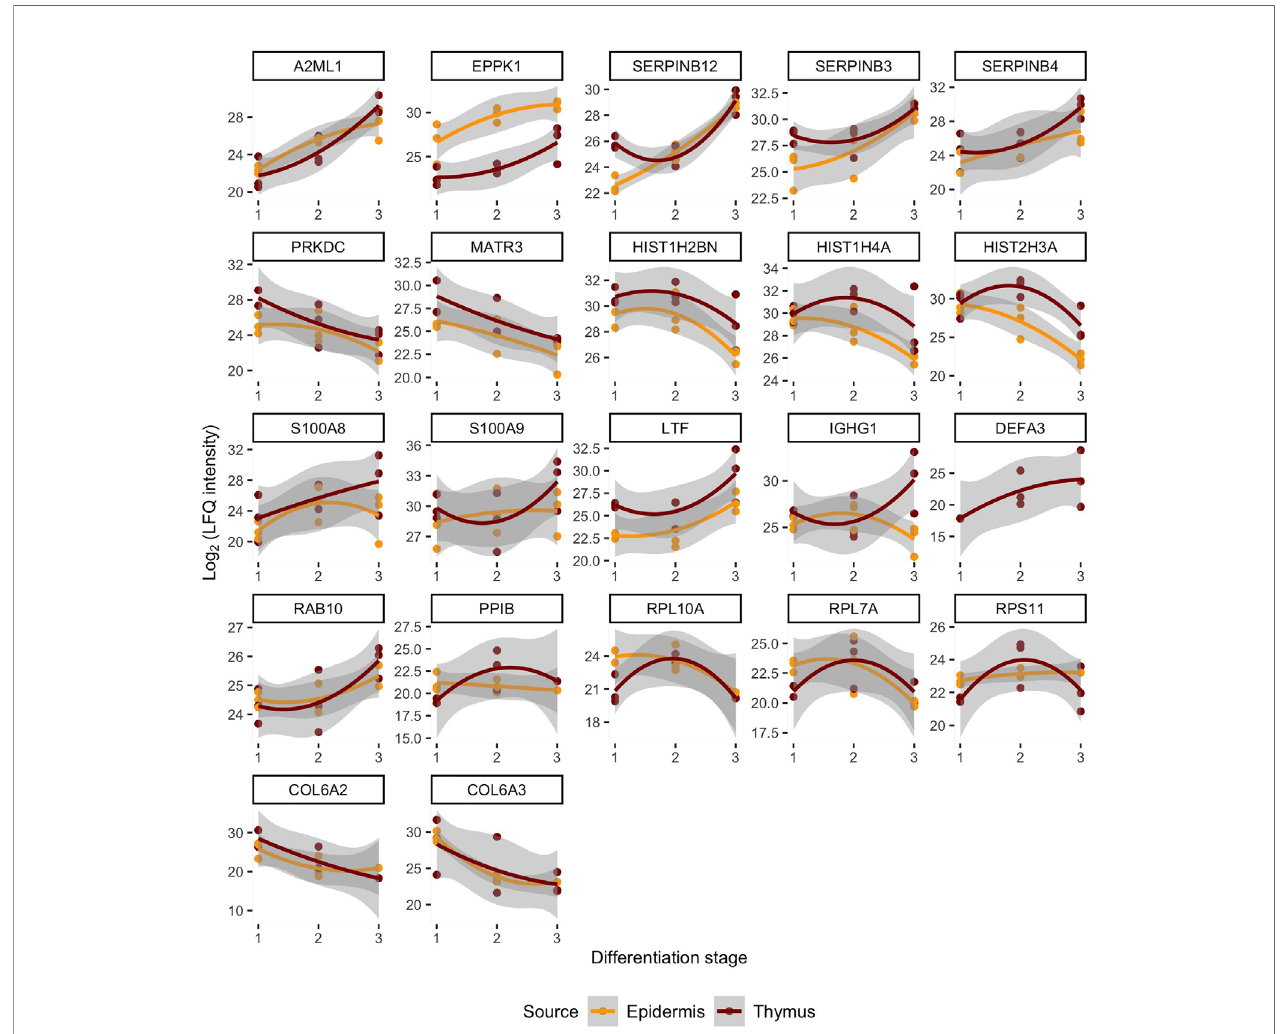
FIGURE 2 | Similarities of protein levels between epidermis and thymus with respect to the differentiation stages and organized based on the localization or function of proteins. The log 2 intensity levels (LFQ) of 22 proteins are shown in all samples. The x-axis corresponds to the source material that is denoted as differentiation stage. The differentiation stages 1, 2, 3 correspond in case of thymus to the mTEC, late mTEC, HC and in epidermis stratum basale, stratum spinosum and stratum granulosum + stratum corneum. The loess regression lines connect the values in those stages representing the change in protein levels during differentiation. Figure ’ s fi rst line shows proteins that are more speci fi c to the epidermis, the second line corresponds to the nuclear proteins, the third one to in fl ammation related proteins, the fourth line to the translation associated proteins and fi nal fi fth one to the